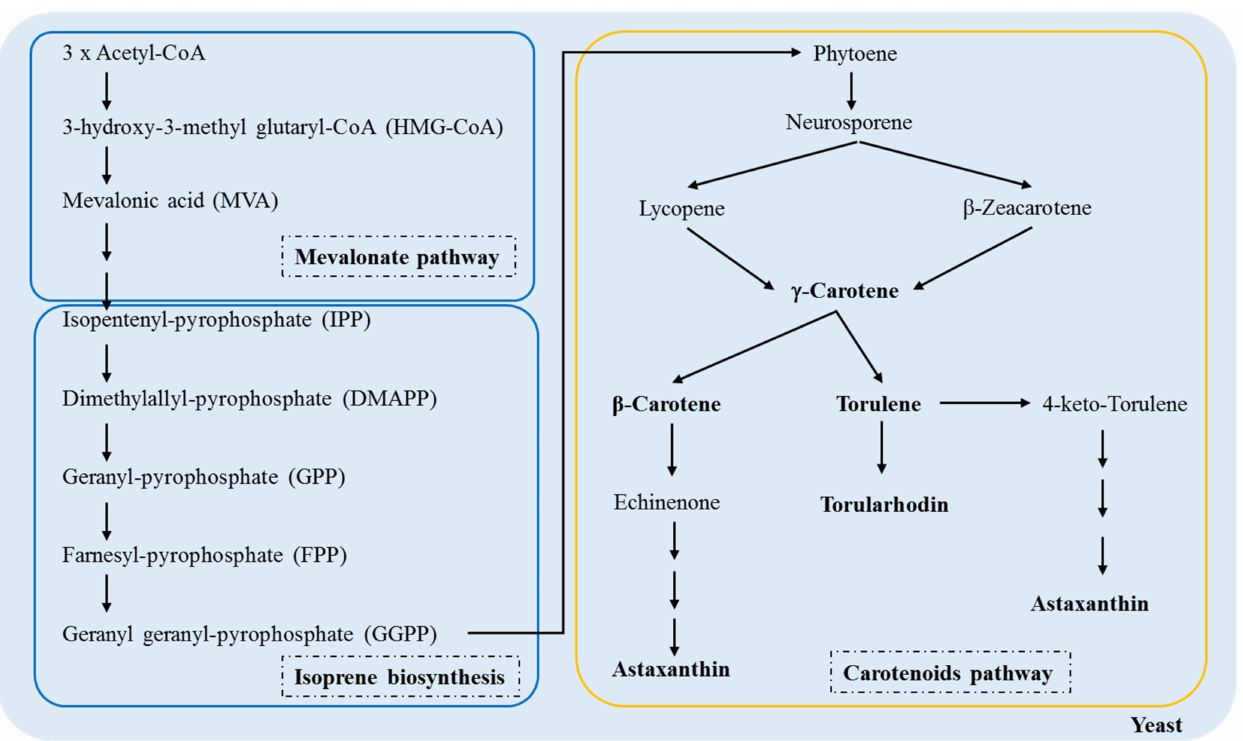
Figure 3. Biosynthetic pathway of the carotenoid production in yeasts, adapted from Frengova & Beshkova